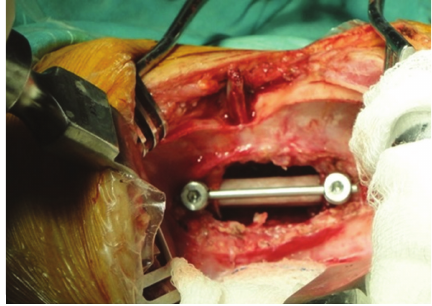
Figure 2: Anterior instrumentation with structural autogenous fibula and autogenous rib graft.